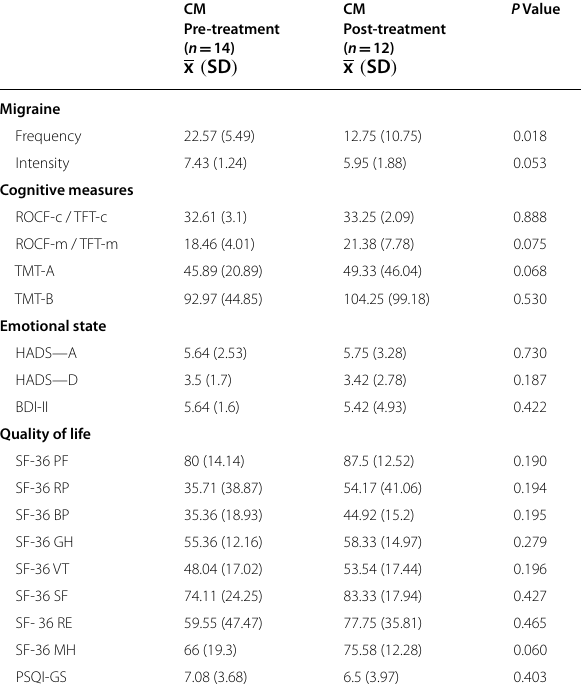
Table 6 Results of the quality of life and cognition tests in the subgroup of patients with CM and normal mood at baseline ( n 14) and after three months of preventive treatment ( n =